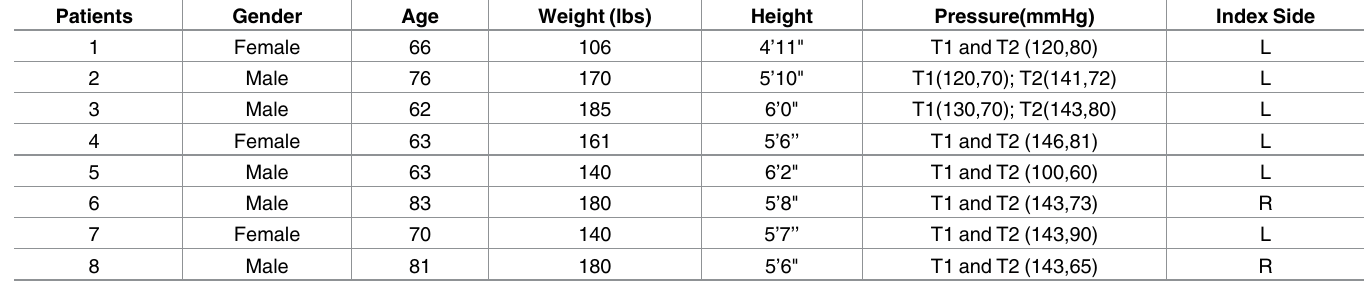
Table 1. Patient information and pressuredata at baseline and follow-up when available (Scan time intervals were about 18 months; L: left carotid artery;R: right carotid artery). Patients